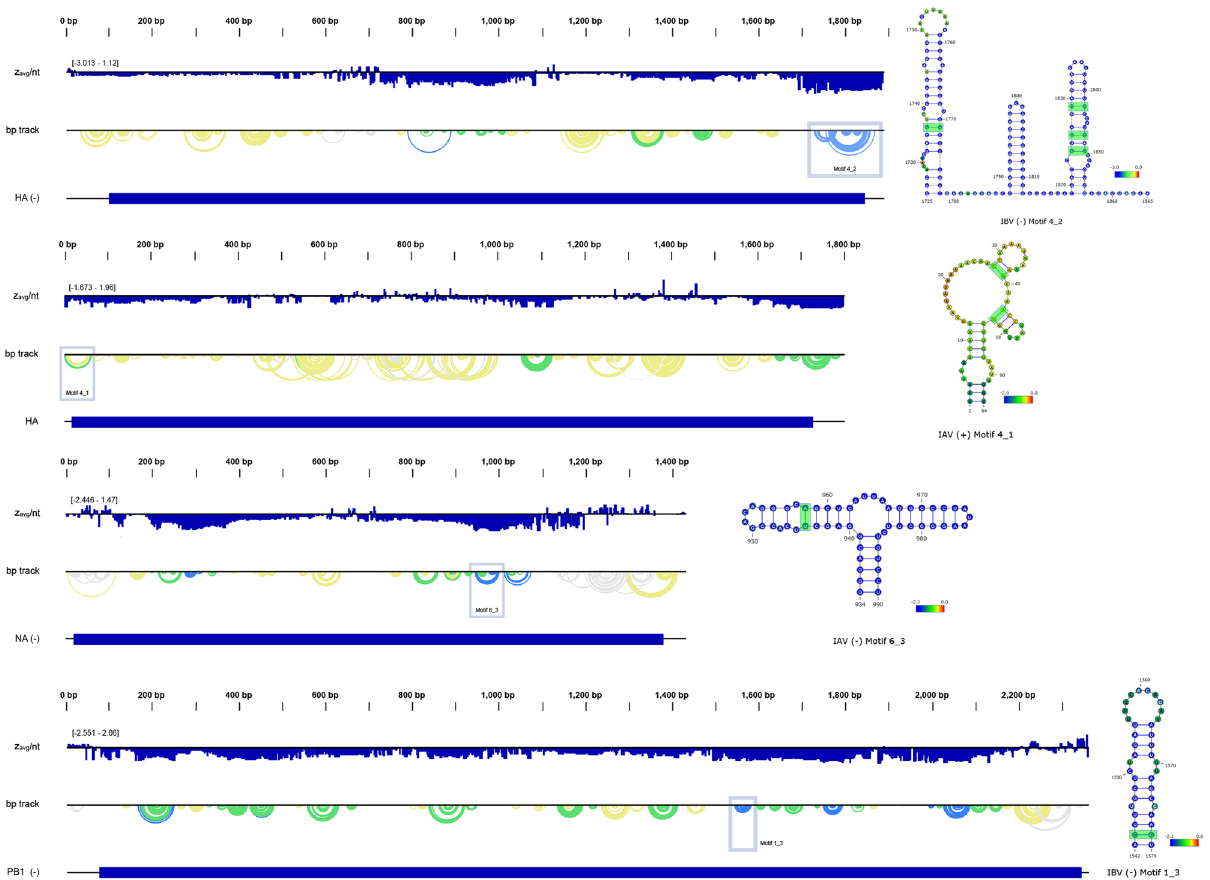
Figure 3. ScanFold analysis for motifs (top to bottom panels, respectively) IAV ( +) 4_1, IAV (−) 6_3, IBV (−) 1_3, and IBV (−) 4_2 (locations designated with blue boxes). The base pair track (bp track) shows arcs correlating to base pairings, where blue arcs have a < −2 score, green arcs have a < −1 z-score, yellow arcs have a < 0 z-score, and gray arcs have a z-score > 0. The R-Scape calculations showed observed base pair covariance (highlighted in green), but the number of observe covarying pairs fell below the expected value (given the sequence alignment). ScanFold per nt z avg are overlaid in each nucleotide circle, with blue designating < −2 z avg . Structural images were adapted from VARNA, and the genome illustrations were adapted from